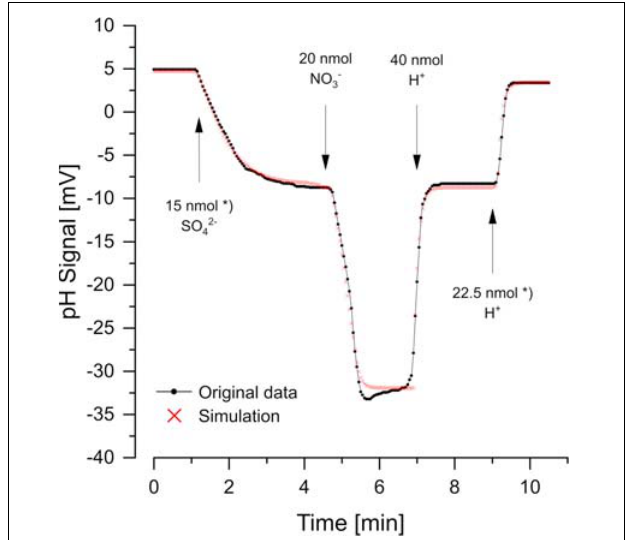
FIGURE 2 | Scalar pH changes correlated with sulfate and nitrate reduction by Desulfovibrio desulfuricans CSN. A cell suspension with OD 436 = 1 was incubated at 30 ◦ C in H 2 -saturated 150 mM KCl, before small pulses of 1 mM Na 2 SO 4 , NaNO 3 , or HCl (in 150 mM N 2 -flushed KCl) were added. The red dots show the simulation obtained with proton.exe (parameters see Supplementary Material , standard deviations see Supplementary Table 1 ). *Data from Krekeler and Cypionka, 1995. Note that a satisfying simulation was obtained only if additions of 15 nmol sulfate and 22.5 nmol H + (second calibration pulse) were assumed, while the original publication says 20 nmol sulfate and 30 nmol H + . Even without simulation by proton exe , it is obvious that the second H + pulse gave a far smaller response than the 30/40 of the first one of 40 nmol H + . Further sulfate and H + additions in the original experiment (Krekeler and Cypionka, 1995) confirmed the scalar consumption of 1.5 H + per reduced